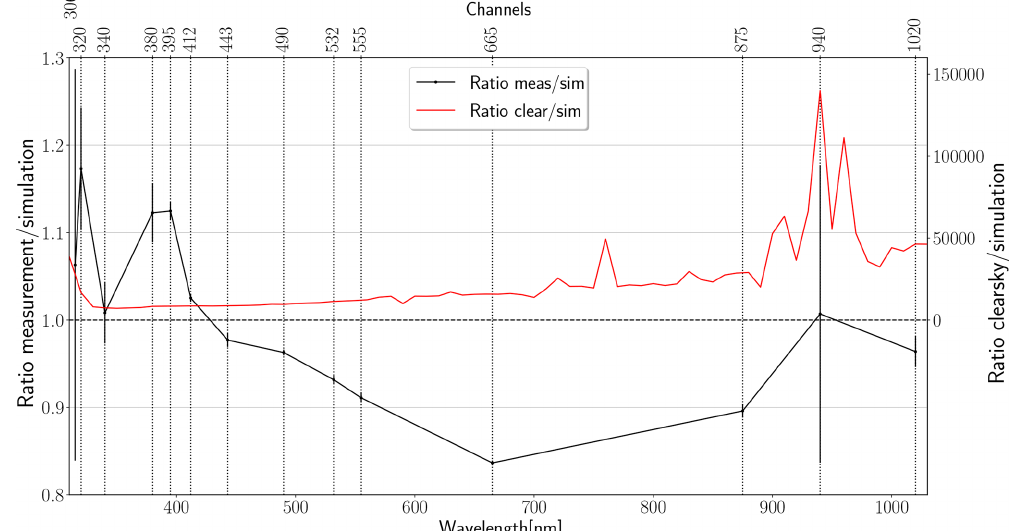
Figure 17. Spectral irradiance during totality (17:20UTC). The black curve shows the deviation of the measurements from the totality simulations, averaged over the 12 data points during totality (17:19:48–17:20:00UTC). The error bars indicate 1 σ deviation of the original values from the mean. Vertical lines indicate the position of the measurement channels. The red curve shows the ratio of the simulated clear-sky irradiance (i.e., without lunar occultation) to simulated totality irradiance at